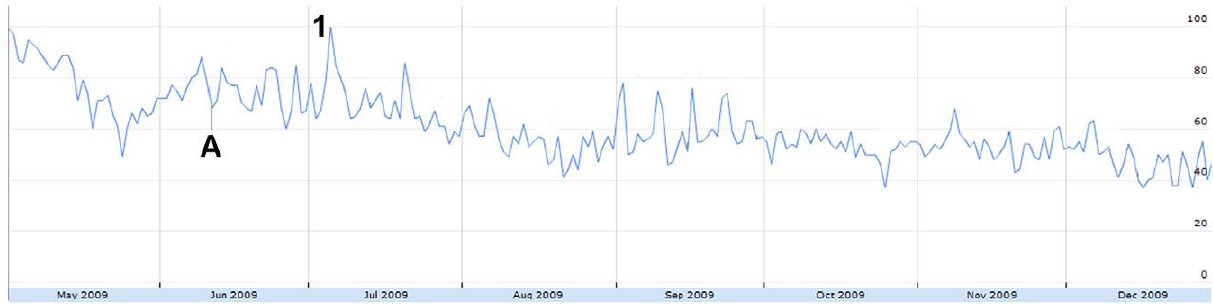
Figure 6. The relative proportion of tweets expressing humour from May 1 to December 31, 2009. Figure was scaled to the highest peak on July 5 where 9.82% of all tweets expressed misinformation. The peak was assigned a score of 100. A=June 11: WHO pandemic level 6 announcement. 1=July 5: Harry Potter actor Rupert Grint has H1N1.